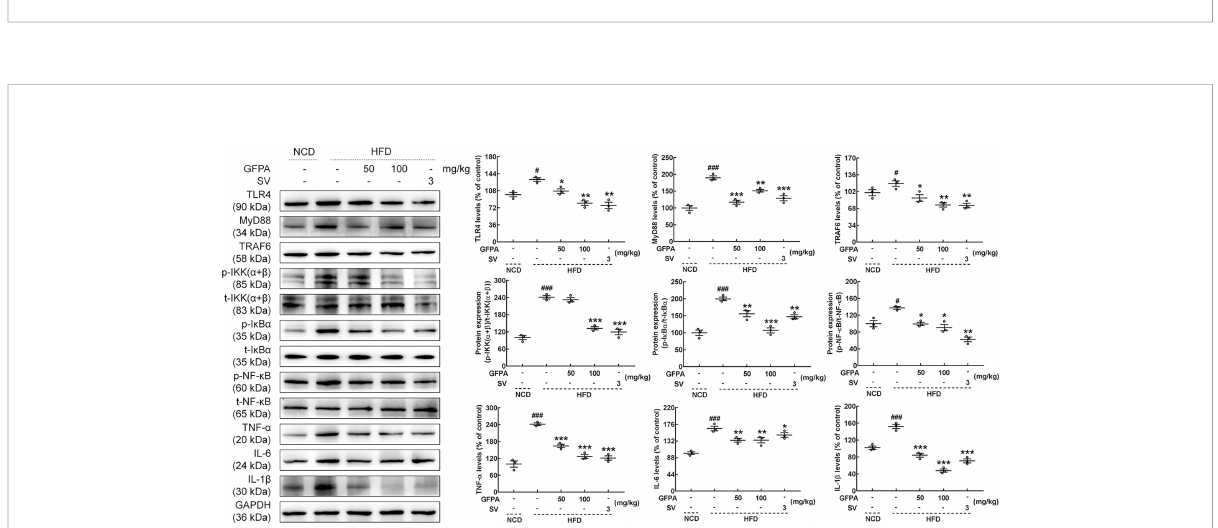
FIGURE 6 GFPA attenuated meta fl ammation by regulating TLR4/NF- k B signaling in the livers of mice with DIO. GFPA suppressed the expression levels of TLR4, MyD88, TRAF6, TNF- a , IL-6 and IL-1 b and the phosphorylation levels of IKK( a + b ), I k B a and NF- k B in the livers of HFD-fed mice. Quanti fi cation data were normalized to glyceraldehyde-3-phosphate dehydrogenase (GAPDH) or the corresponding total protein concentration. Data are expressed as means ± S.E.M. (n = 3). # p < 0.05 and ### p < 0.001 versus NCD-fed mice; * p < 0.05, ** p < 0.01 and *** p < 0.001 versus HFD-fed